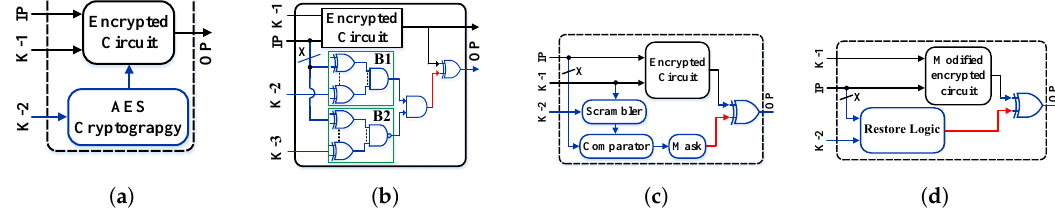
Figure 9. Prohibition Satisfiability (SAT) attack methodologies (specified by a blue color) ( a ) Advanced Encryption Standard (AES) cryptography: conceals part of the correct key-bits ( b ) Anit-SAT: produces incorrect output at a single primary output for all incorrect combination keys unless the correct one is applied ( c ) SAT Attack Resistant Logic Locking (SARLock): inverts the outputs of the encrypted circuit unless the correct key is provided ( d ) tenacious and traceless logic locking (TTLock): modifies the logic cone circuit by flipping its outputs unless the secret key is